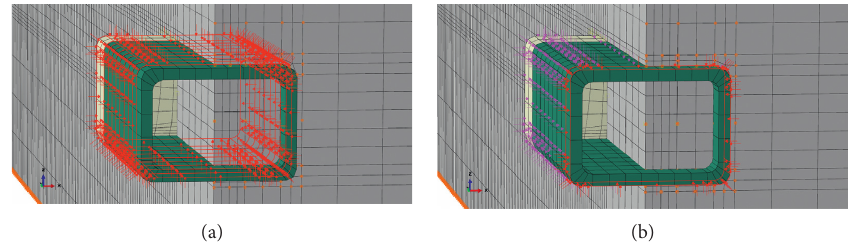
Figure 4: Grouting pressure distribution. (a) The pipe has been jacked in. (b) The pipe is being jacked